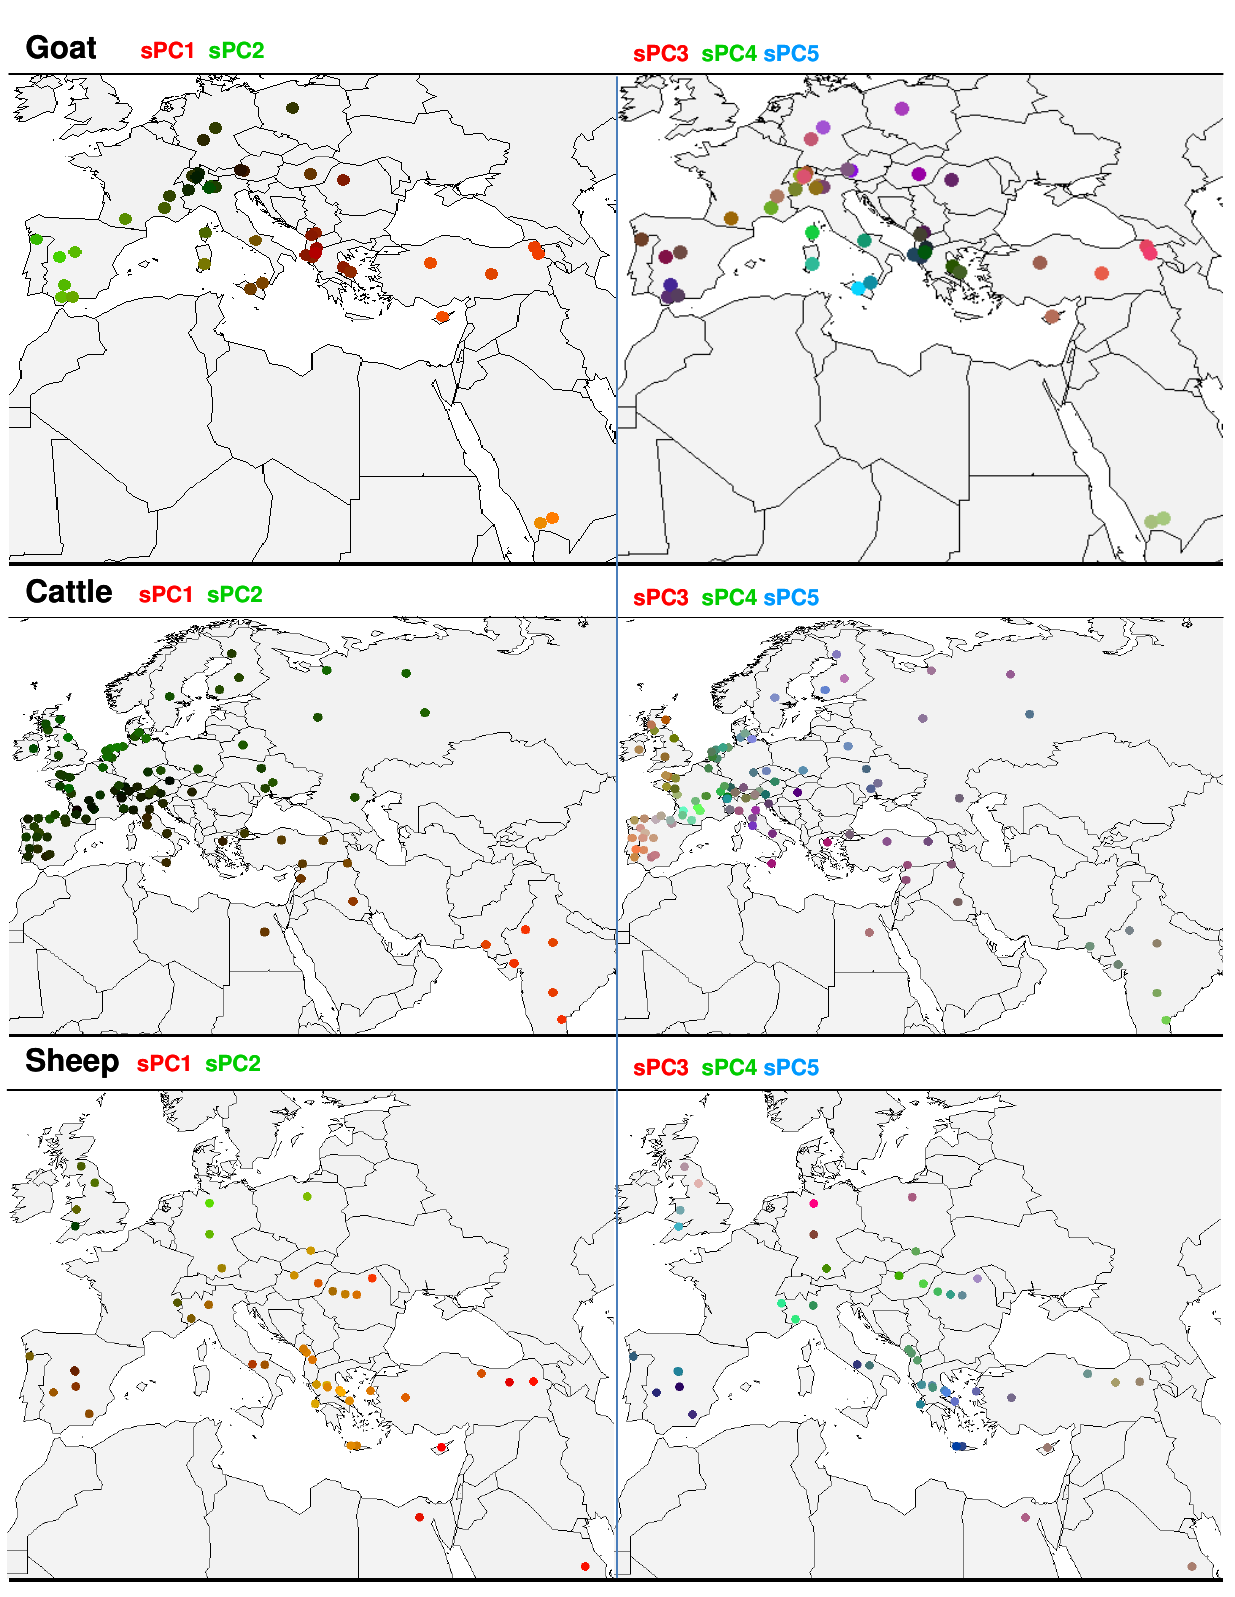
Figure 3. sPCA of goat, sheep, and cattle breeds. Coordinates have been displayed with the color as indicated, and the intensity of the color is proportional to the sPC